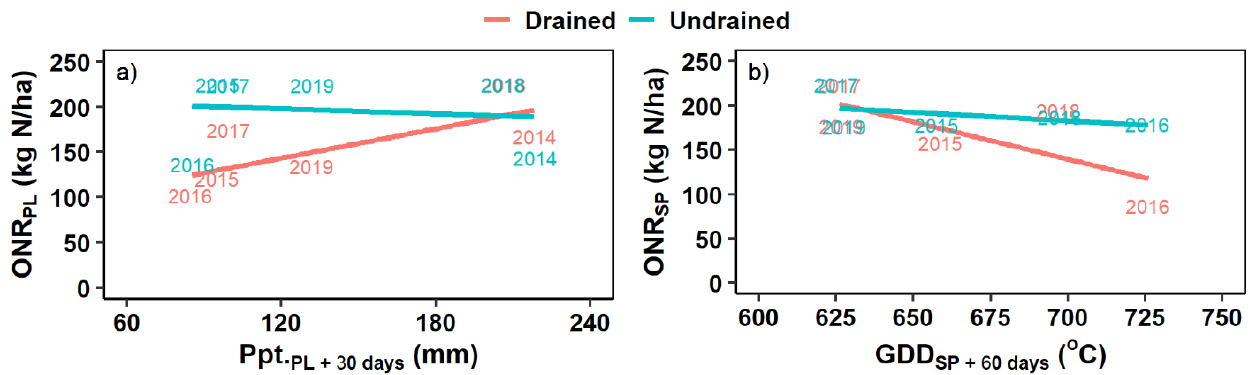
Figure 4. ( a ) Optimal nitrogen rate (ONR) for fertilizer applied entirely at planting (PL) (ONR PL ) as related to cumulative precipitation (Ppt.) from the date of PL fertilizer application plus 30 days (Ppt. PL+30 days ) from 2014 to 2019; and ( b ) ONR for fertilizer split applied (SP) 45 kg N ha − 1 at planting and the remainder of the rate at V6 to V8 (ONR SP ) as related to cumulative growing degree days (GDD) from the date of SP fertilizer application plus 60 days (GDD SP+60 days ) from 2014 to 2019.